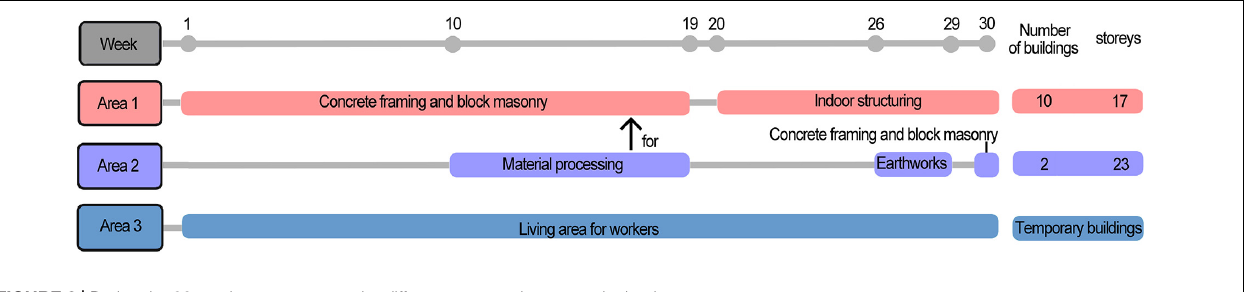
FIGURE 2 | During the 30-week measurement, the different construction stages in the three areas. TABLE 1 | Ten types of typical noise sources, sound-producing machinery, annual presence time, operator types, and on-site measurement distance.